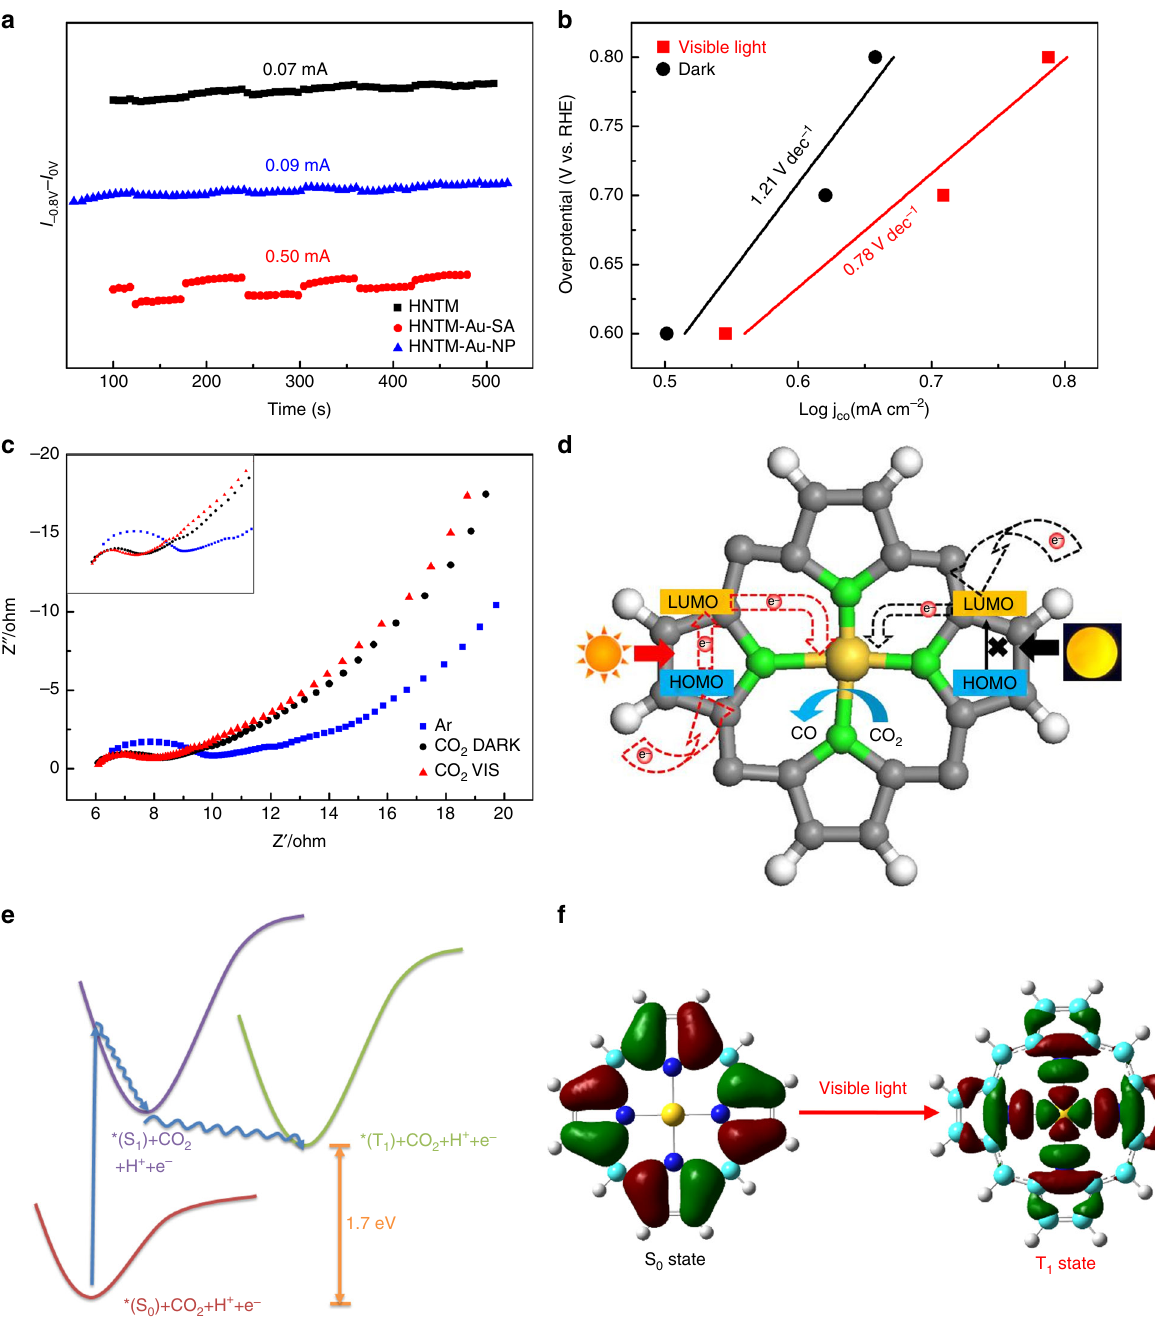
Fig. 6 Mechanism for photo-coupled electrochemical and electrochemical CO 2 reduction. a The difference between photocurrent response at − 0.8 V and 0 V on HNTM-Au-SA, HNTM-Au-NP, and HNTM. b Tafel plots of HNTM-Co-SA under visible light (red line)/dark (black line). c EIS spectra of HNTM-Co- SA in Ar-(blue line)/CO 2 -saturated 0.1 M KHCO 3 under visible light (red line)/dark (black line). d The electron transfer pathways under visible light and dark are shown in the left and right parts, respectively. e Transition orbital of T 1 state under visible light. f Schematic representation of the excited states of